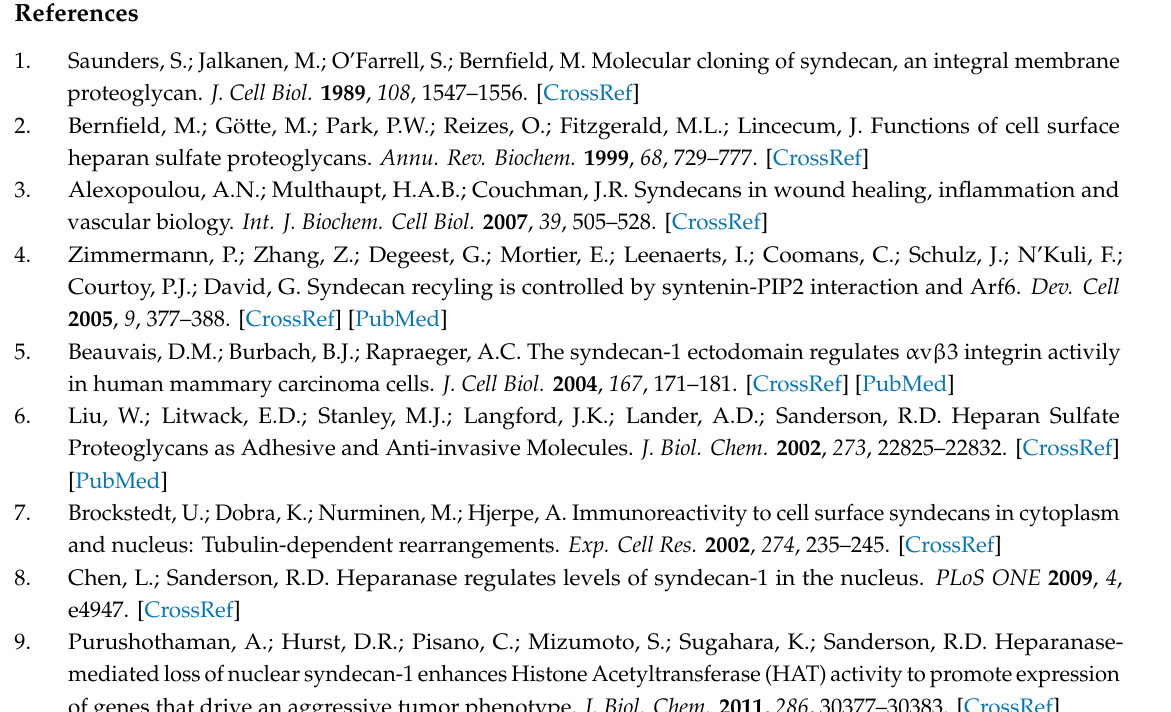
Figure S1: Western blot showing the presence of SDC1. Figure S2: The workflow adopted for the analysis. Figure S3: Proteins interacting with SDC1 according to the STRING database. Figure S4: The figure shows overrepresented pathways predicted using WebGestalt tool. (a) The overrepresented pathways of all the interacting proteins of SDC1. (b) The over-represented pathways of nuclear proteins interacting with SDC1. The bars are colored on the basis of FDR. Figure S5: The figure shows the link between the pathways (Ribosome, mRNA surveillance, RNA transport and Spliceosome). Table S1: The table includes all the identified proteins in the control and SDC-IP samples and the sub-cellular localization of the proteins interacting with